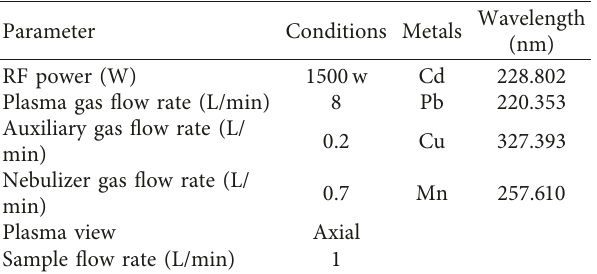
Table 2: ICP-OES operating conditions for each analyzed